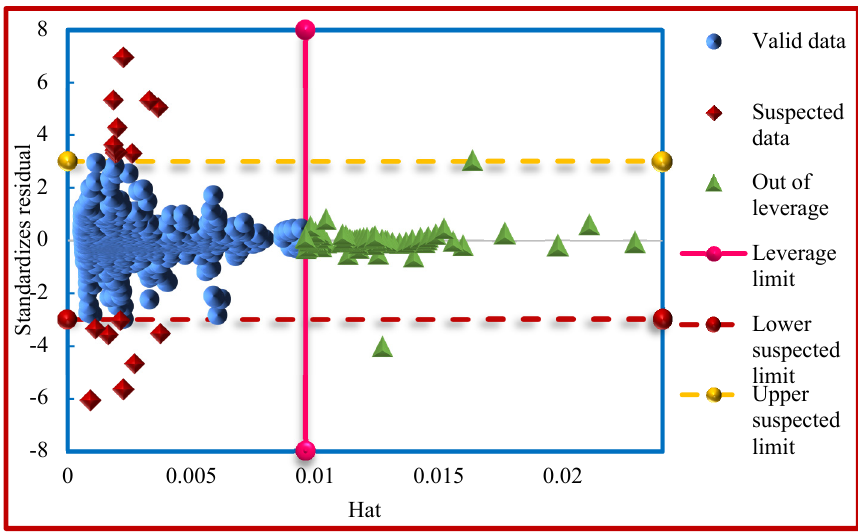
Figure 16. The Williams plot of the whole dataset for the CMIS model based on Model (II).